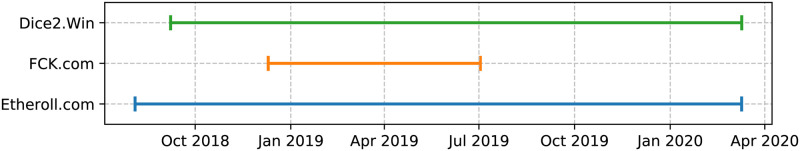
Transaction data gathering timelines for each of the three decentralised gambling applications studied.